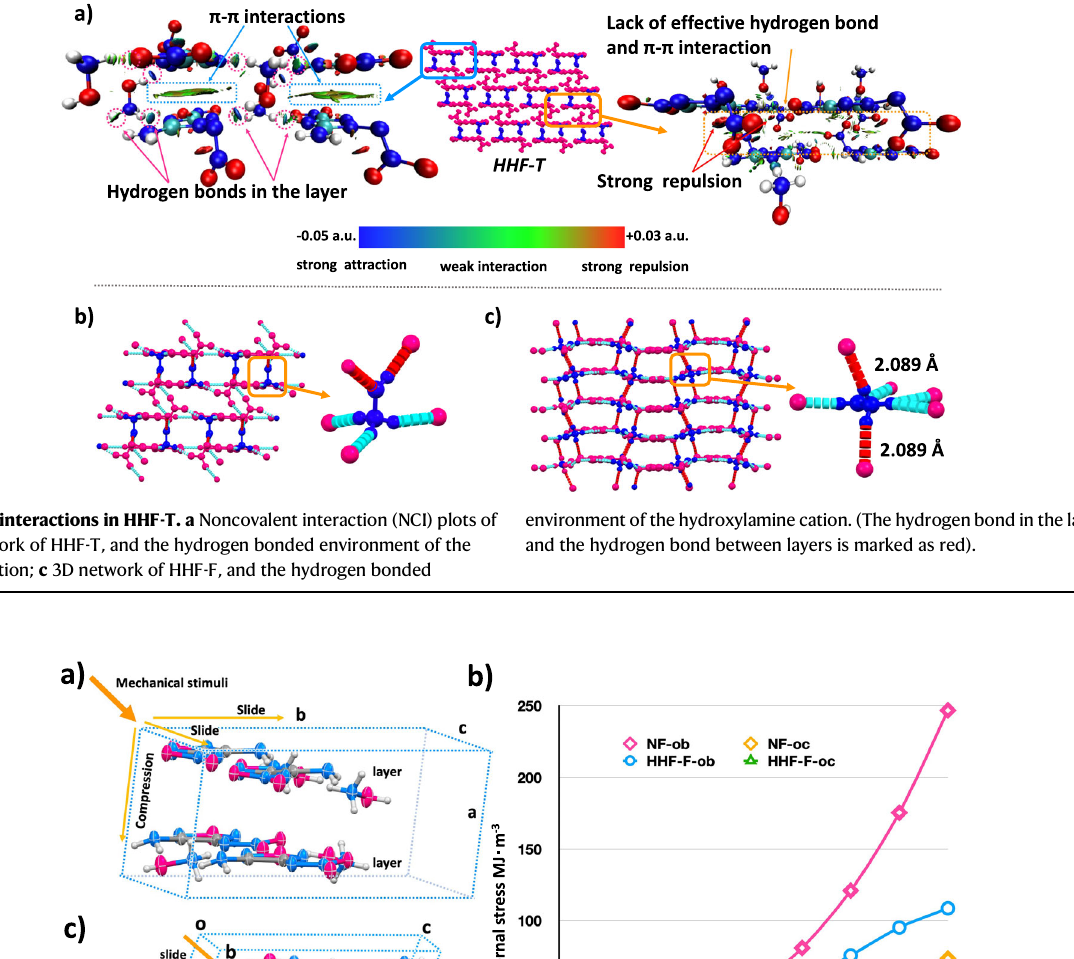
and NF (NF-ob and NF-oc). c Plot showing the sliding constraint of the NF crystal unit cell along the b